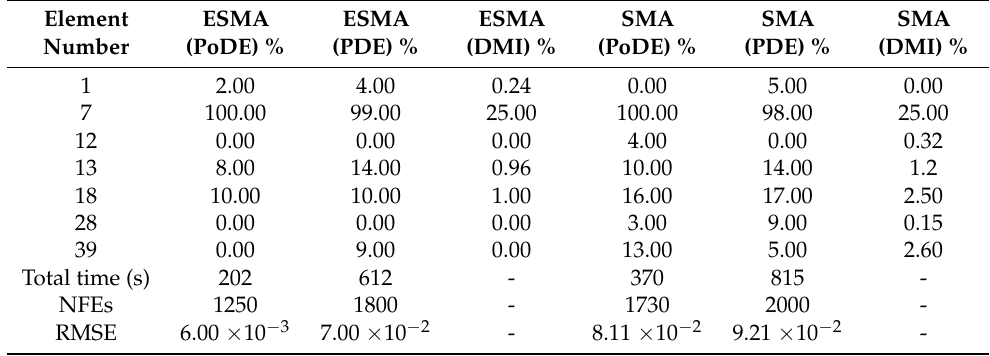
Table 11. PoDEs, PDEs, and DMIs for the four-story steel structure.